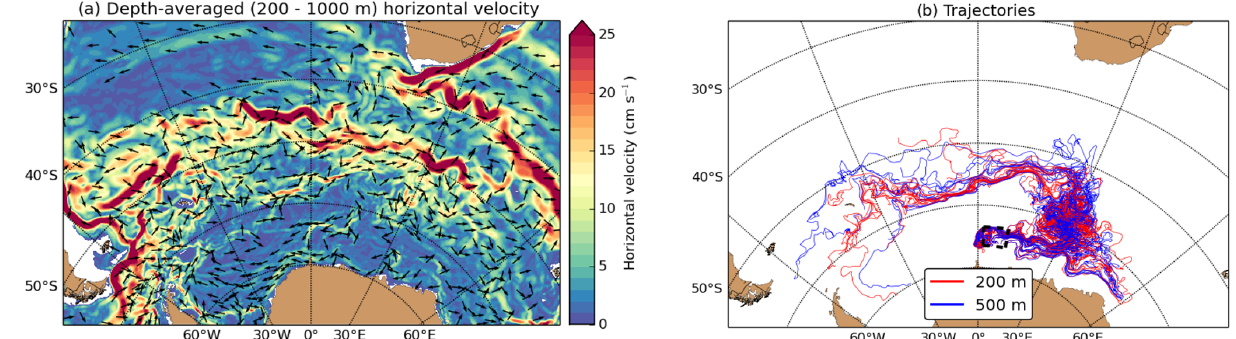
Figure 7. (a) Time-mean (model years 150–250) and depth-averaged (200–1000m) horizontal velocity field (arrows), with the speed indi- cated in the contours. The arrows indicate the direction of the flow (not to scale) and are only shown for speeds larger than 2cms − 1 . (b) The backtracked trajectories for 10 years for some particles (initially spaced at 1 ◦ × 1 ◦ , 30 particles per initial depth level) which are initially released at 200m (red curves) and 500m (blue curves) depths in the polynya region (dashed outlined